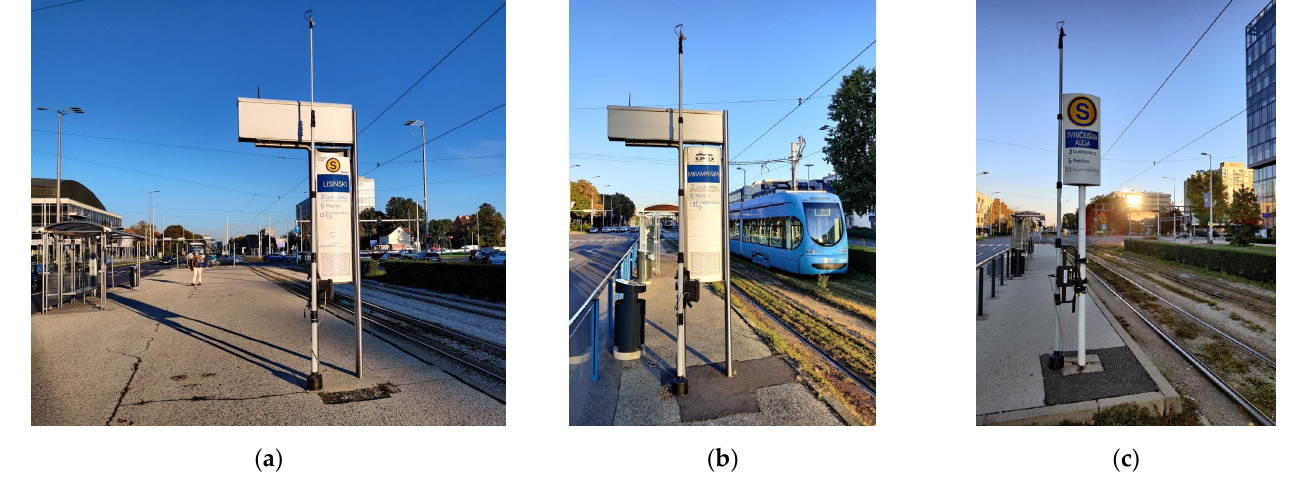
Figure 6. Miovision Scout devices mounted on stop signs: ( a ) Stop-1; ( b ) Stop-2; ( c )